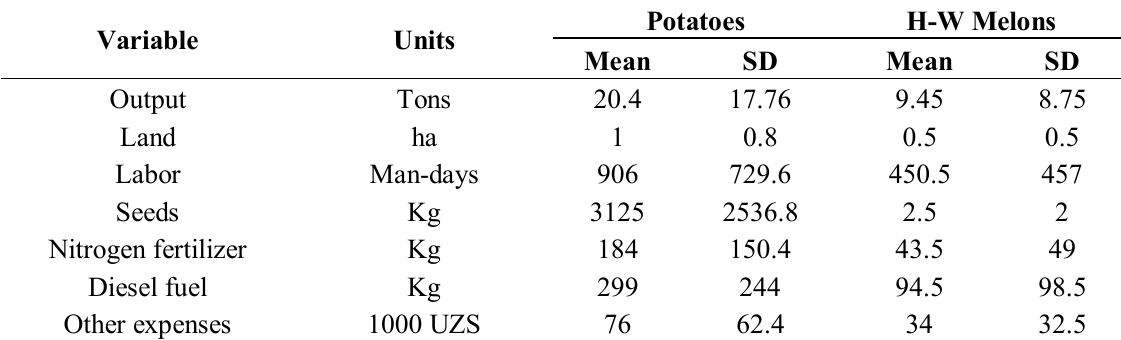
Table 1. Summary statistics of variables used in the